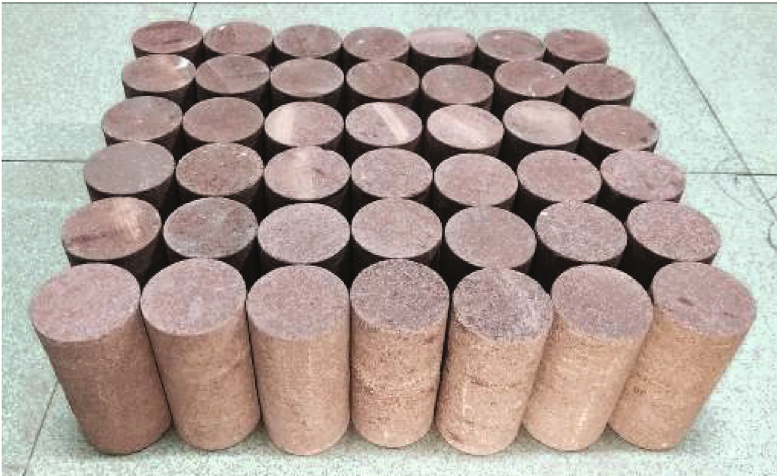
Figure 2: Red sandstone specimens.